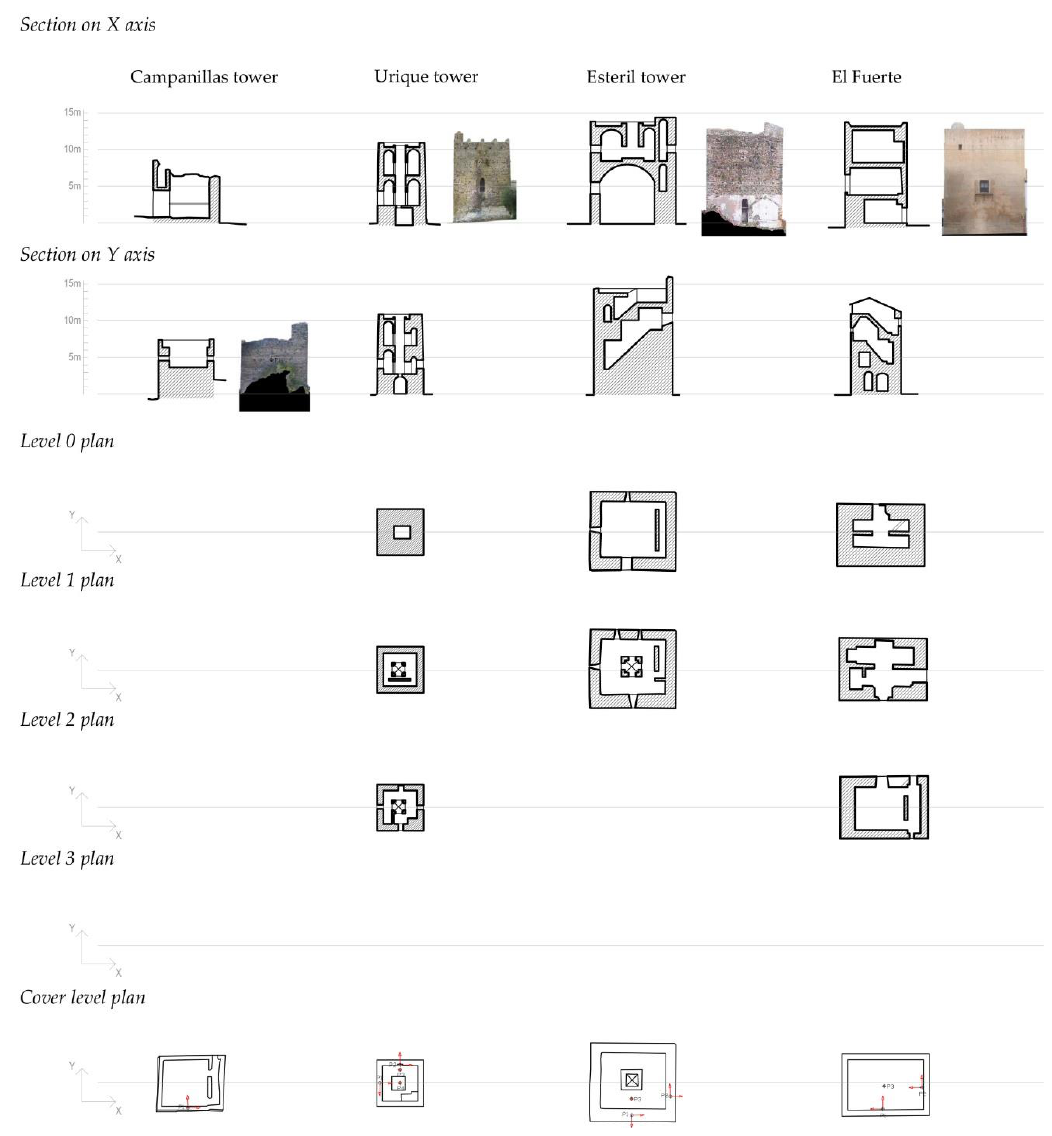
Figure 1. Description of elevations and plans of the towers in this study.